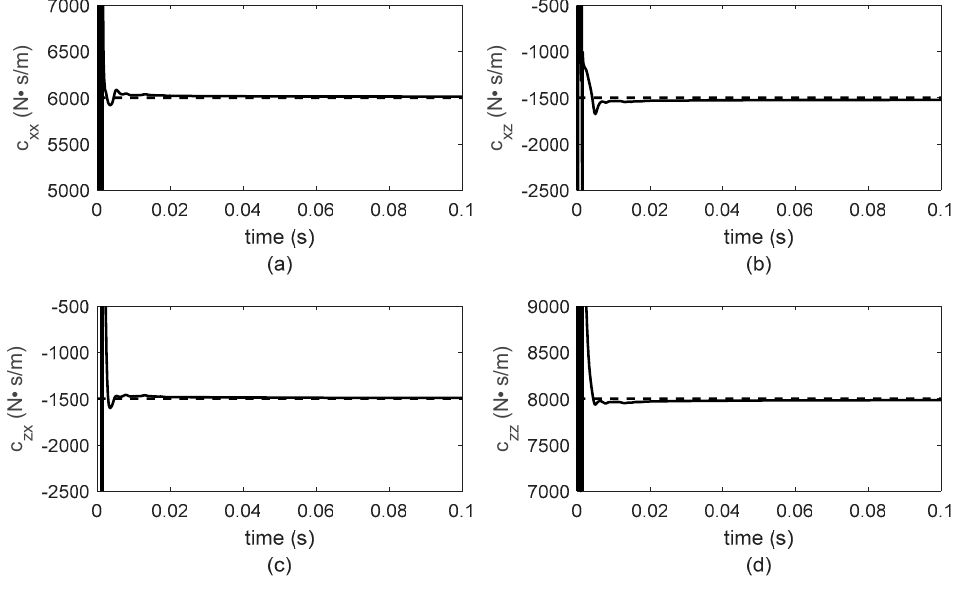
xx , ( b ) c xz , ( c ) c zx , ( d ) c zz